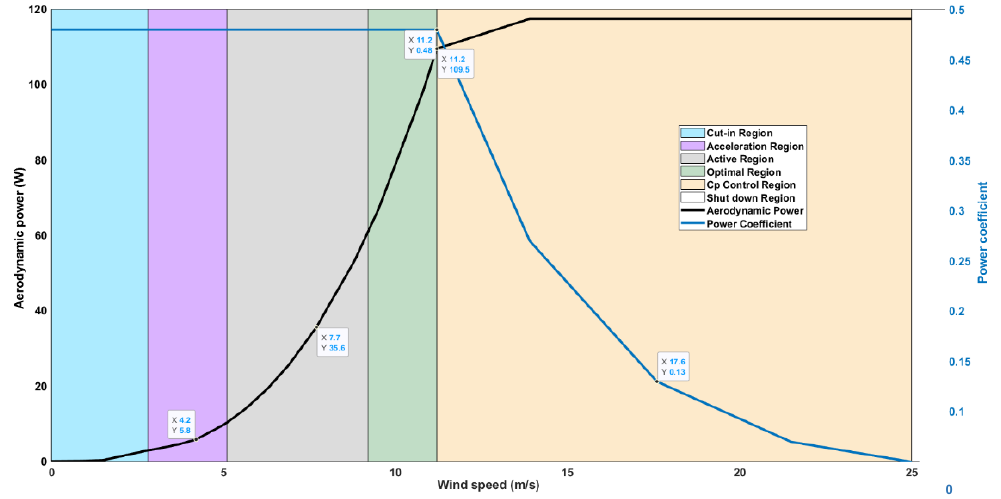
Figure 2. Variation of the optimal power coefficient with wind speed.